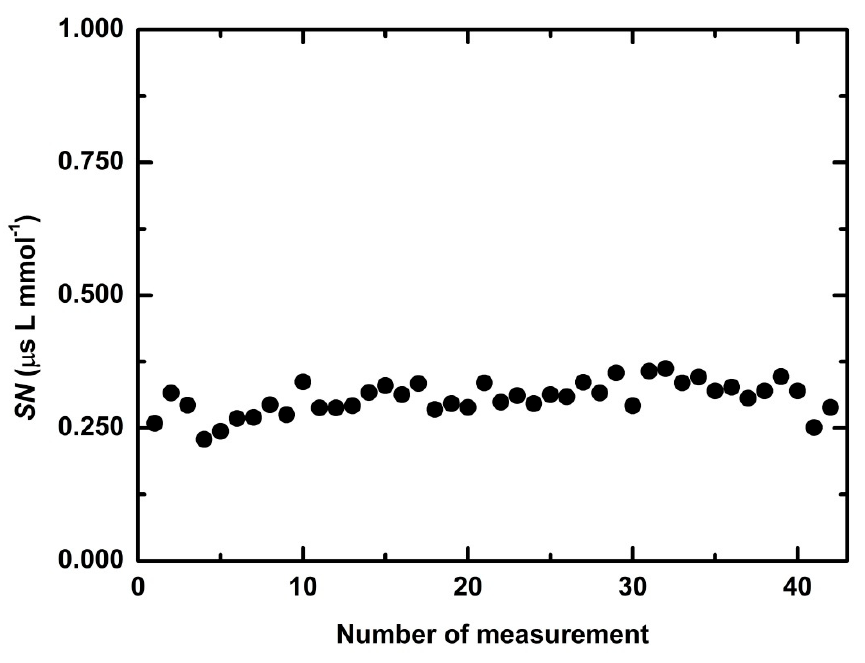
Figure 7. Sensitivity of the optical sensitive layer in 42 repeated measurements during two months.